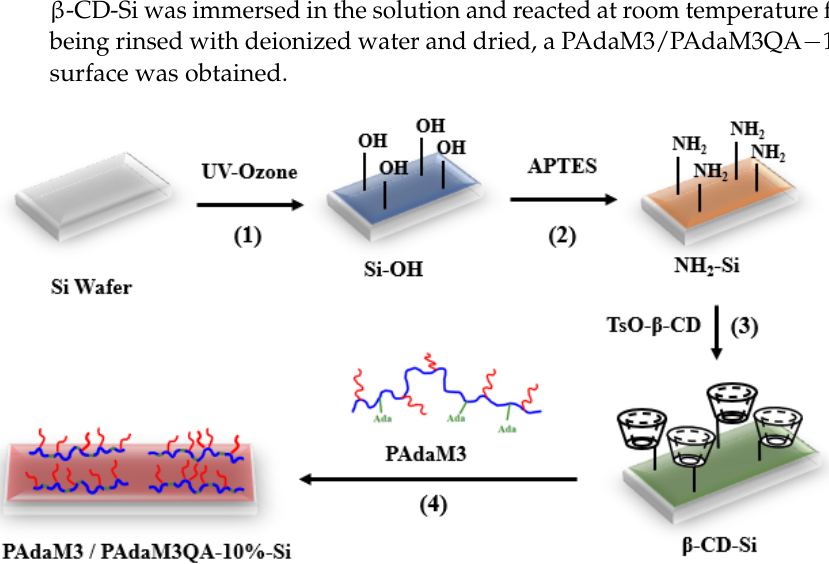
Figure 13. The schematic illustration of PAdaM3/PAdaM3QA − 10%-Si.